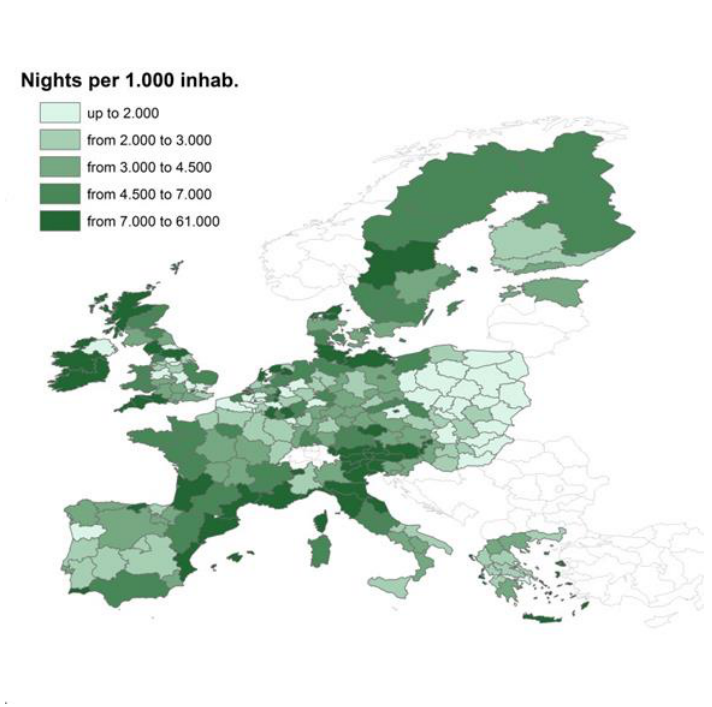
Figure 2: The Size of Touristic Enterprises in European